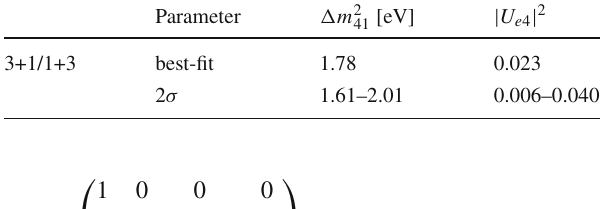
Table 3 2 σ estimated values of the mixing parameters in one sterile neutrino scenario